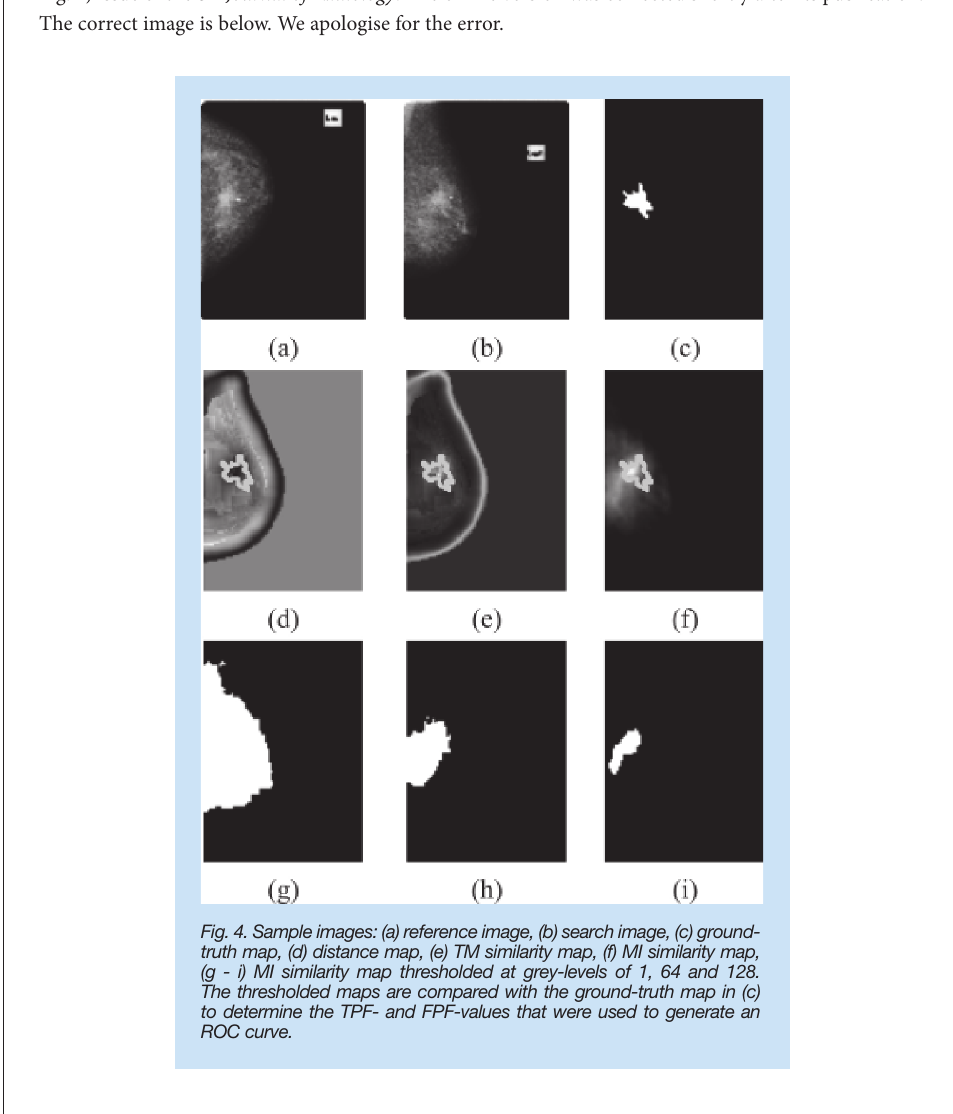
The incorrect image was used in the printed version of the previous (August 2009, Vol. 13 no. 3, page 53, Fig. 4) issue of the SA Journal of Radiology . The online version was corrected shortly after its publication. The correct image is below. We apologise for the error.